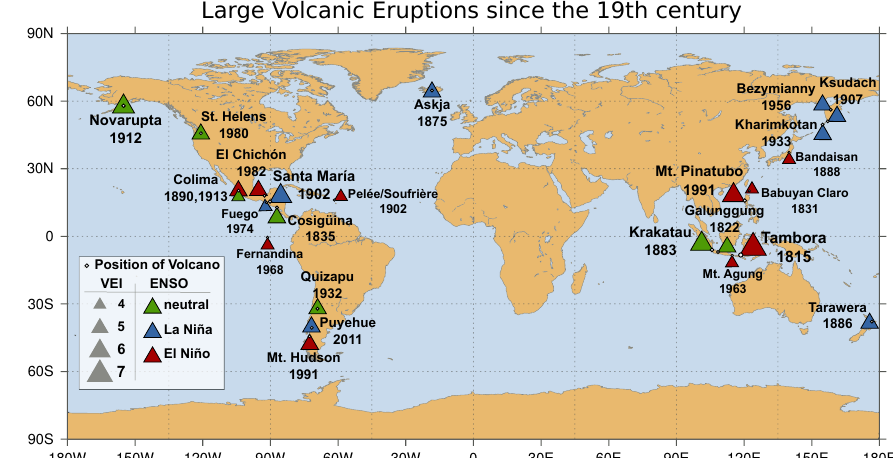
Figure 1. Large volcanic eruptions since the 19th century. The size of the triangle indicates the volcanic explosivity index (VEI) (Newhall and Self, 1982), from Simkin and Siebert (1994) and the Smithsonian Institution (http://www.volcano.si.edu). The filled colour shows the El Niño–Southern Oscillation (ENSO) event in the first winter after the eruption from Cook et al. (2009) until 1870 and from Wolter and Timlin (2011) from 1871 until present. In the case of Fuego, Santa María, Babuyan Claro and Galunggung the second winter after the eruption is considered for the definition of the ENSO phase.